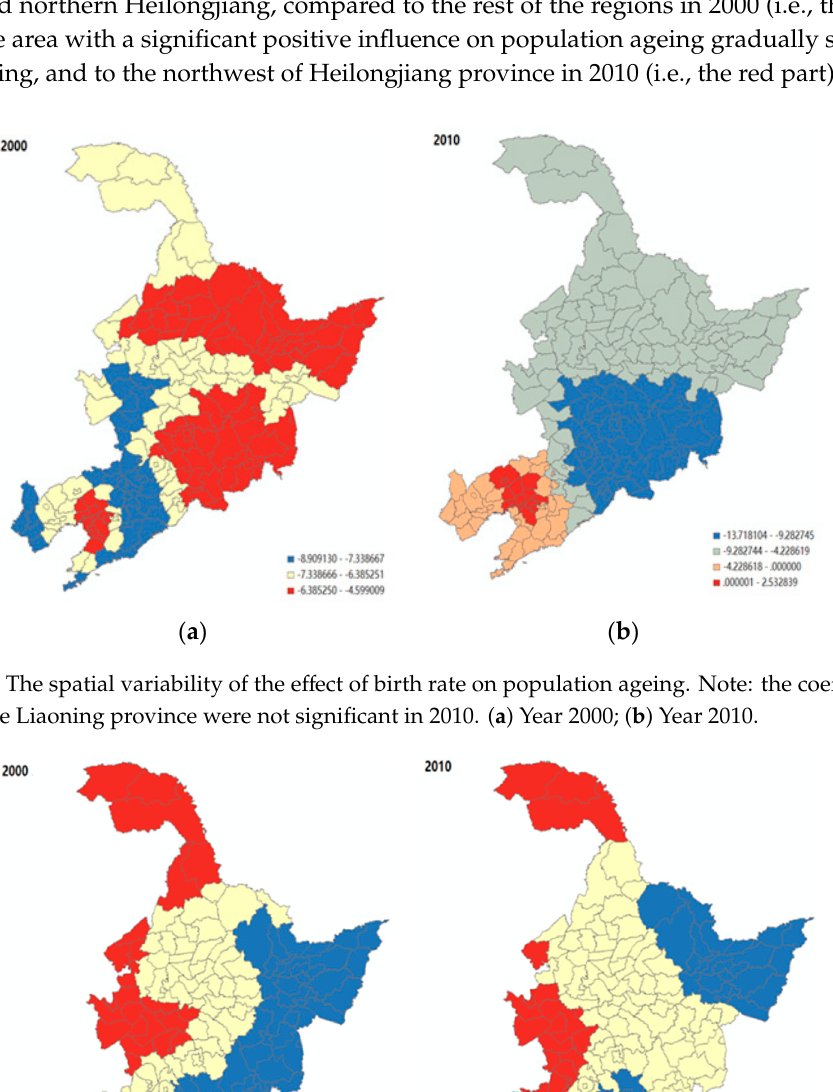
( b ) Figure 6. The spatial variability of the effect of industrial structure on population ageing. ( a ) Year 2000; ( b ) Year 2010. As far as healthcare conditions are concerned, a clear spatial pattern can be portrayed, as shown in Figure 7a. In western Jilin and northeastern Liaoning (i.e., the red part), there was a significantly positive association between the local population ageing and the level of healthcare conditions, with a set of coefficients within the range of 2.6–4.7. However, this positive association can be no longer observed in 2010 for almost the entire northeast region. Finally, the spatial variation of the effect of population mobility (see Figure 7b) hints that the level of this negative impact was overall higher in the less-developed areas, including the northern border of Jilin, eastern Jilin, and eastern Liaoning (i.e., the blue part) in 2010.